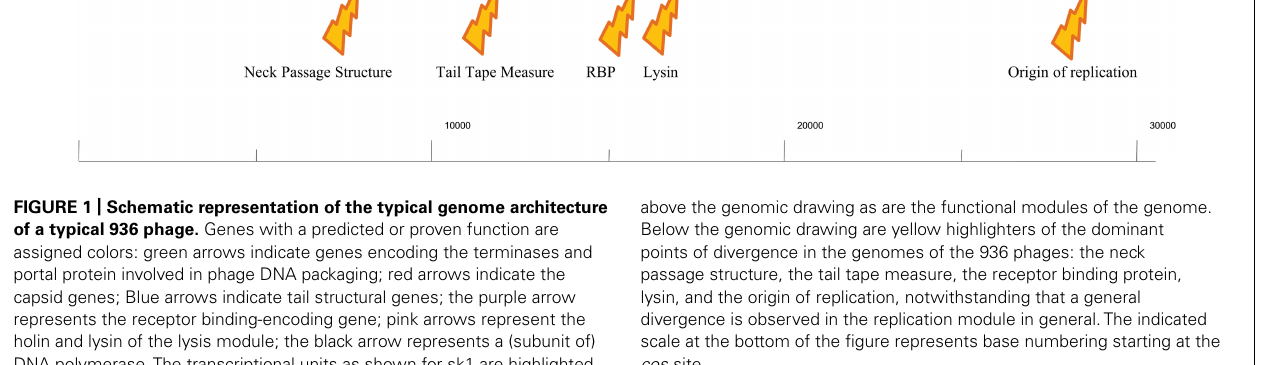
FIGURE 1 | Schematic representation of the typical genome architecture of a typical 936 phage. Genes with a predicted or proven function are assigned colors: green arrows indicate genes encoding the terminases and portal protein involved in phage DNA packaging; red arrows indicate the capsid genes; Blue arrows indicate tail structural genes; the purple arrow represents the receptor binding-encoding gene; pink arrows represent the holin and lysin of the lysis module; the black arrow represents a (subunit of) DNA polymerase.The transcriptional units as shown for sk1 are highlighted